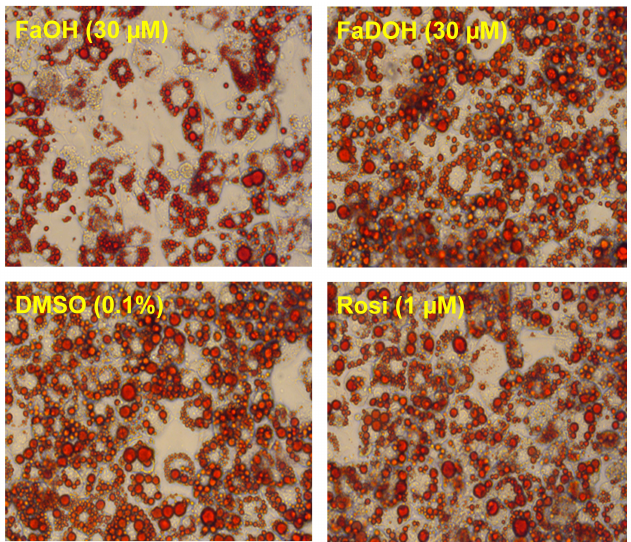
Figure 7. Effect of FaOH (30 µ M), FaDOH (30 µ M), vehicle (0.1% DMSO) and Rosi (1 µ M), respectively, on adipocyte differentiation (MDI protocol) in 3T3-L1 preadipocyte. Cells were stained with Oil Red O on day